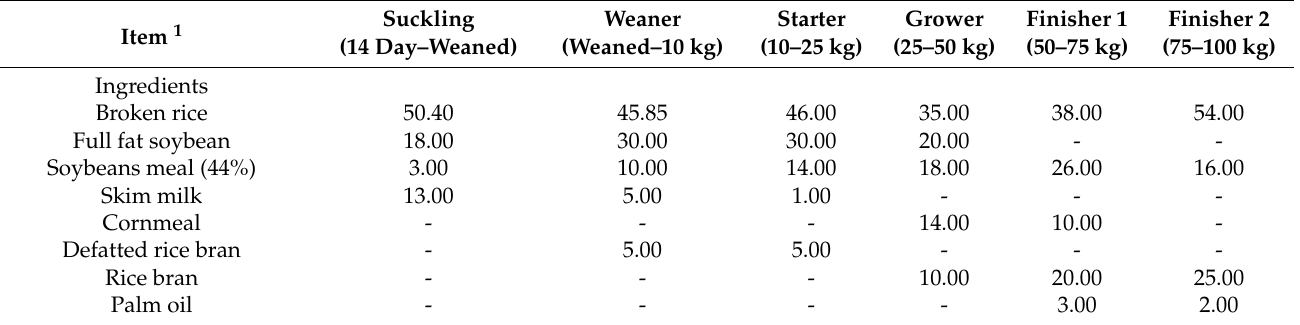
Table 1. Composition and calculated nutrient content of the experimental diets from the suckling to the finisher 2 phases (g/100 g as the feed